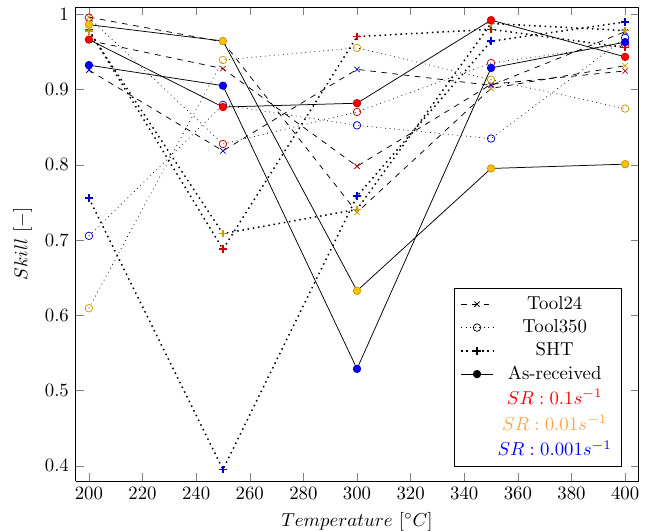
Figure 11. All 60 test Skill values obtained for the XGB model, shown in relation to temperature. The color represents the strain-rate (SR), the marker and line style are representing the condition.